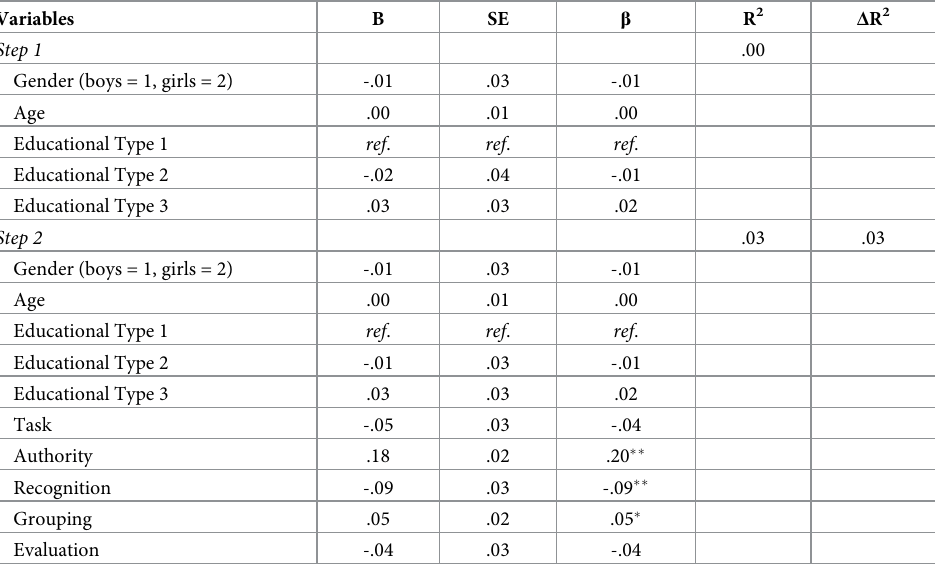
Table 3. Summary of hierarchical regression analysis for variables predicting controlled